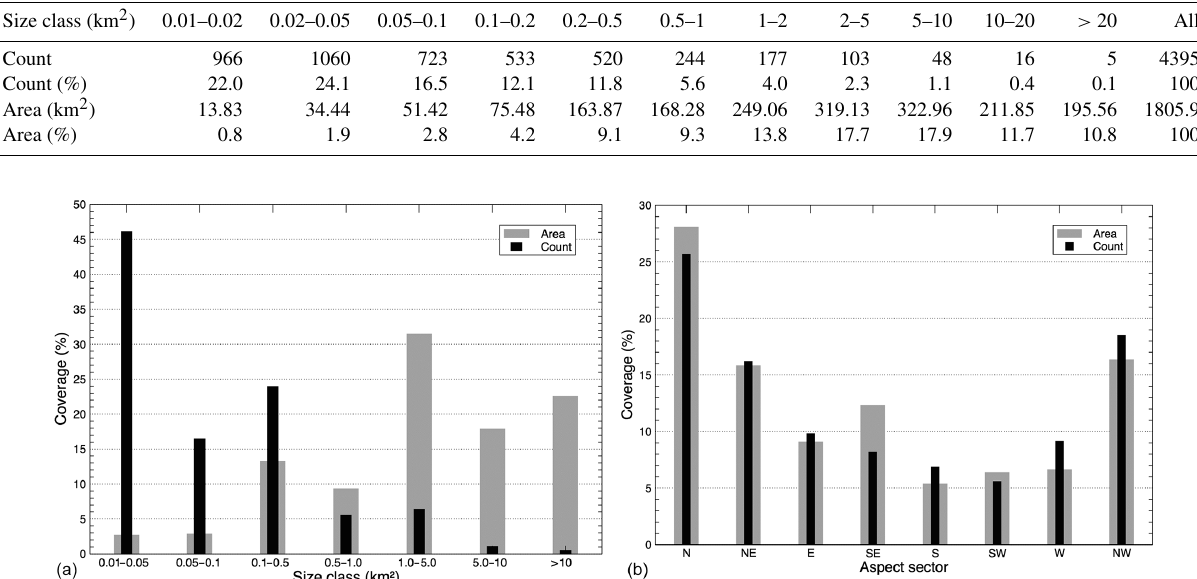
( − 1 . 1 % a − 1 ). Considering the assumed missing area in the 2003 inventory of about 40 km 2 (glaciers with area gain are 29.4 km 2 larger in 2015/16 than in 2003), a more realistic area loss is − 15 % or − 1 . 3 % a − 1 . This is about the same pace as reported earlier by Paul et al. (2004) for the Swiss Alps from 1985 to 1998/99 ( − 1 . 4 % a − 1 ). An example